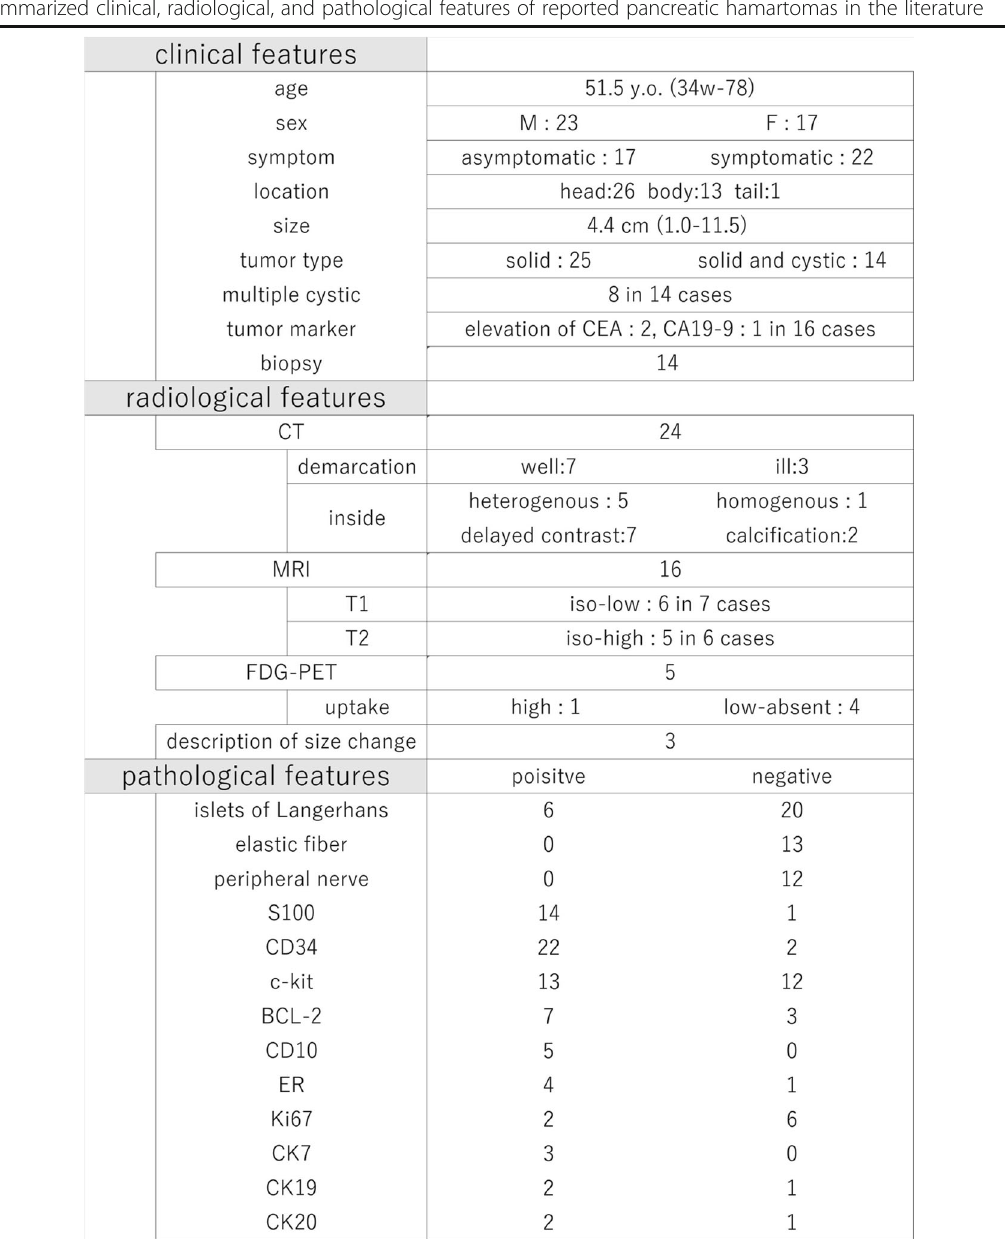
Katayama et al. Surgical Case